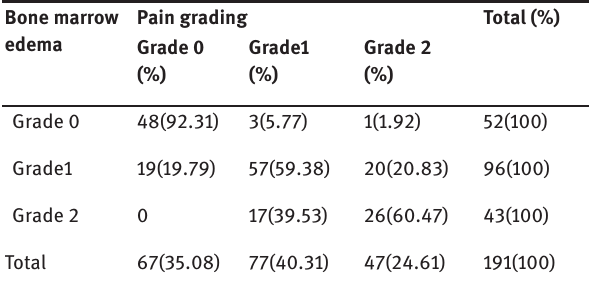
Table 1: Quantitative distribution of hip pain grades in various bone marrow edema grades.